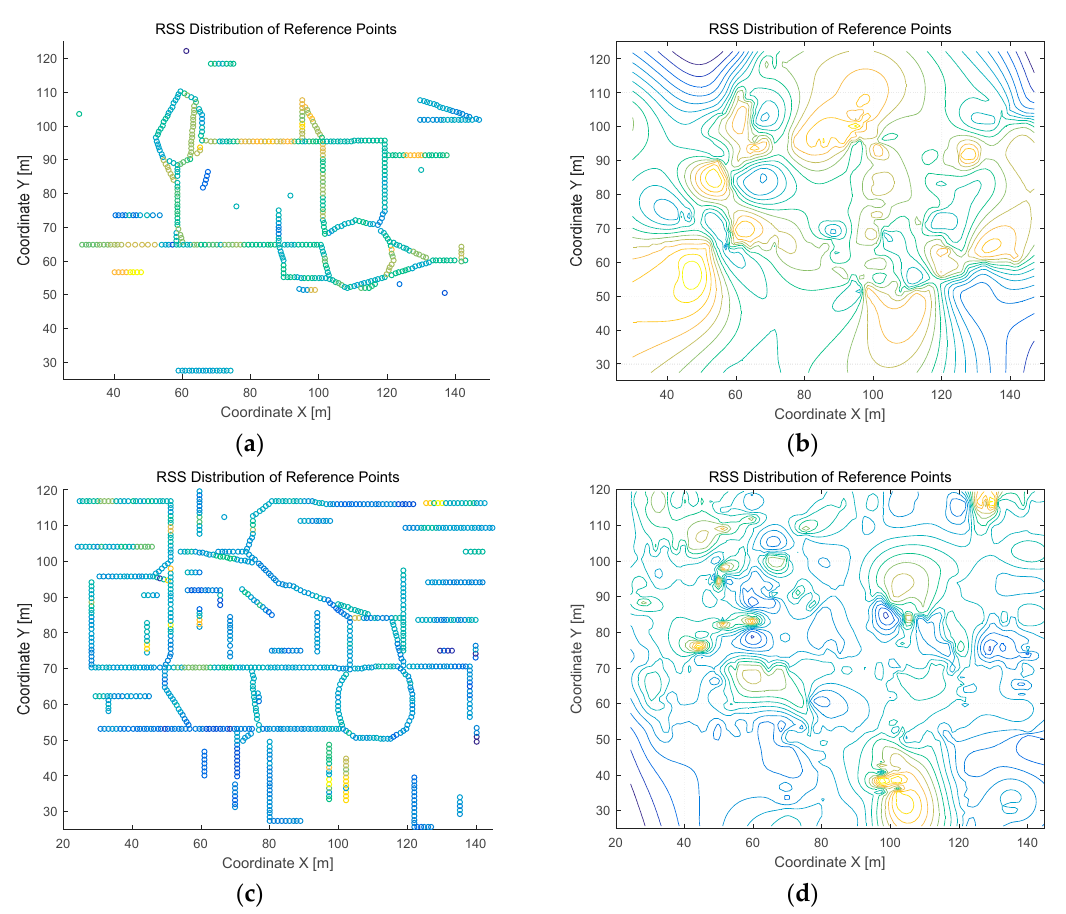
Figure 7. Reference points’ RSSI distribution in Test-bed 2: ( a ) RSSI distribution in the first floor of Test-bed 2 in scatter diagram; ( b ) RSSI distribution in the first floor of Test-bed 2 in contour map; ( c ) RSSI distribution in the second floor of Test-bed 2 in scatter diagram; and ( d ) RSSI distribution in the second floor of Test-bed 2 in contour map.